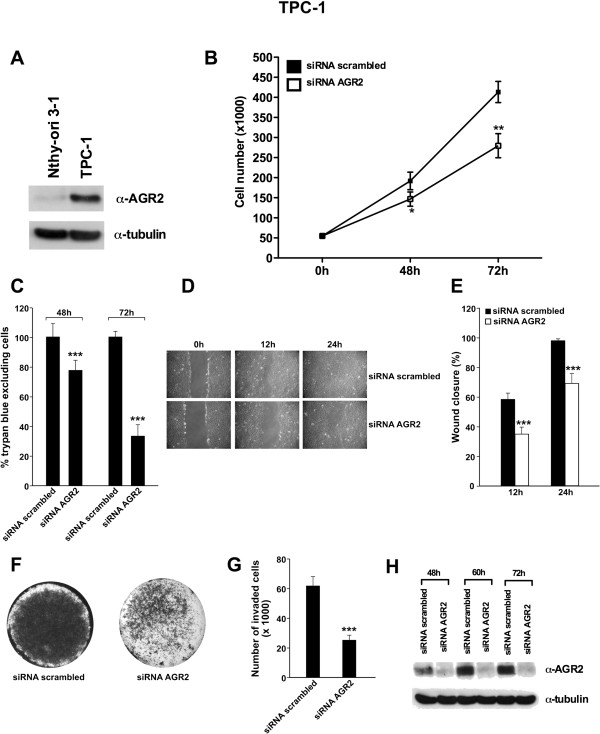
Effects of AGR2 knockdown on TPC-1 cell growth, migration and invasion. A) Expression levels of AGR2 in Nthy-ori 3–1 and TPC-1 cells. Cells were lysed and analyzed by Western blotting with the indicated antibodies. B) TPC-1 cells were transfected with AGR2 siRNA or with scrambled siRNA and counted at different time points. Values represent the average of triplicate experiments ± standard deviations. C) TPC-1 cells were transfected with AGR2 siRNA or with scrambled siRNA; after 48 and 72 hours cells were collected by trypsinization, stained for 10 minutes with trypan-blue and counted in triplicate. The percentage of trypan blue excluding cells compared to cells transfected with scrambled siRNA is reported ± standard deviations. D) TPC-1 cells were transfected with AGR2 siRNA or with scrambled siRNA; after 48 hours a wound was introduced and cell migration into the wound was monitored at 12 and 24 hours. E) Wound closure was measured by calculating pixel densities in the wound area and expressed as percentage of wound closure of triplicate areas ± standard deviations. F) TPC-1 (1 × 105) cells were transfected with AGR2 siRNA or with scrambled siRNA; 48 hours after transfection, cells were seeded in the upper chamber of transwells and incubated for 24 hours; the upper surface of the filter was wiped clean and cells on the lower surface were stained, photographed and counted. This figure is representative of three independent experiments. G) Invasive ability is expressed as number of invaded cells. Values represent the average of triplicate experiments ± standard deviations. H) TPC-1 cells were transfected with AGR2 siRNA or with scrambled siRNA. Cells were harvested at different time points and protein lysates were subjected to immunoblotting with the indicated antibodies. Asterisks indicate P < 0.05 (*), P <0.01 (**) and P < 0.001 (***).